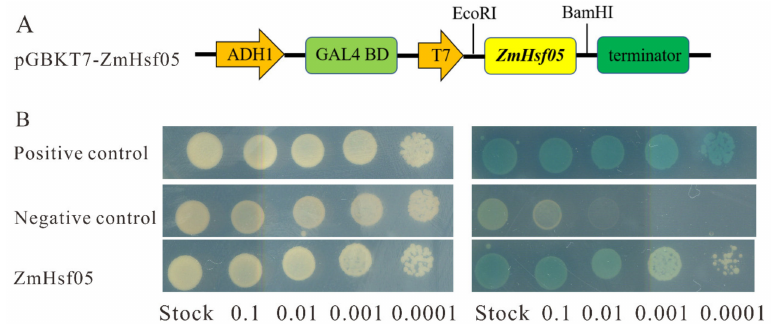
Figure 4. Transactivation activity analysis of ZmHsf05 . ( A ) Schematic diagram of the fused vector used in the experiment. The full length of ZmHsf05 cDNA to the GAL4 DNA-binding domian (GAL4 BD) coding region in the fused vector. Expression of ZmHsf05 was driven by T7, while expression of GAL4 BD was driven by promoter of ADH1 (Alcohol dehydrogenase 1) ( B ) The result of the transactivation activity analysis. The yeast was transformed with positive control, negative control and pGBKT7-ZmHsf05 fused vectors, respectively, and grown on SD/-Trp/-His/-Leu/-X- α -gal triple deficiency medium. Positive control: pGBKT7-53+pGADT7-T, Negative control: